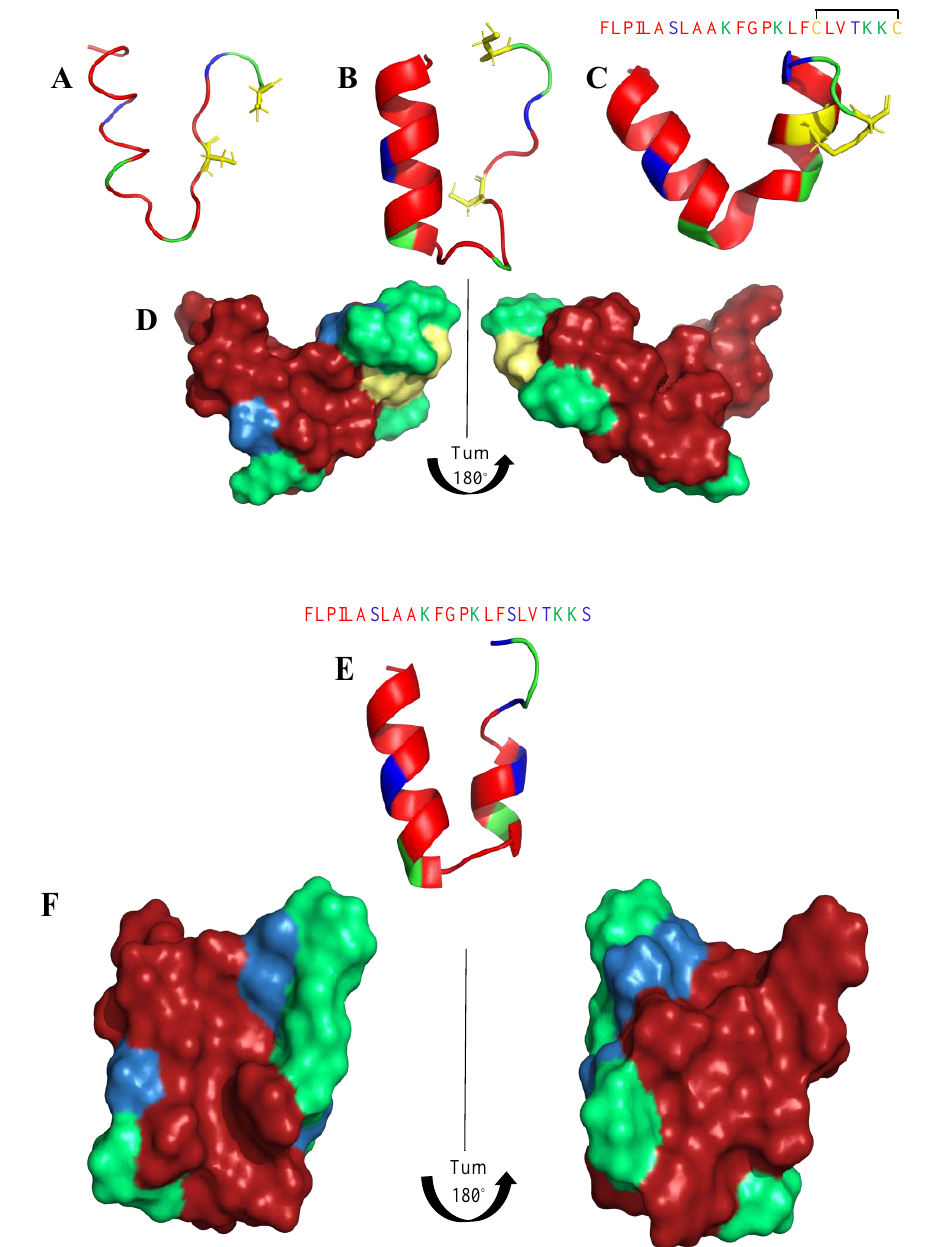
Figure 2. ( A , B ) I-Tasser simulation of brevinin-1BYa ternary structure. ( C , D ) PDB (PDB: 6G4U) ternary structure of brevinin-1BYa. ( E , F ) I-Tasser simulation of [C18S,C24S]brevinin-1BYa ternary structure. Amino acids are colored in red (hydrophobic), blue (hydrophilic), green (positively charged) and yellow (cysteine).